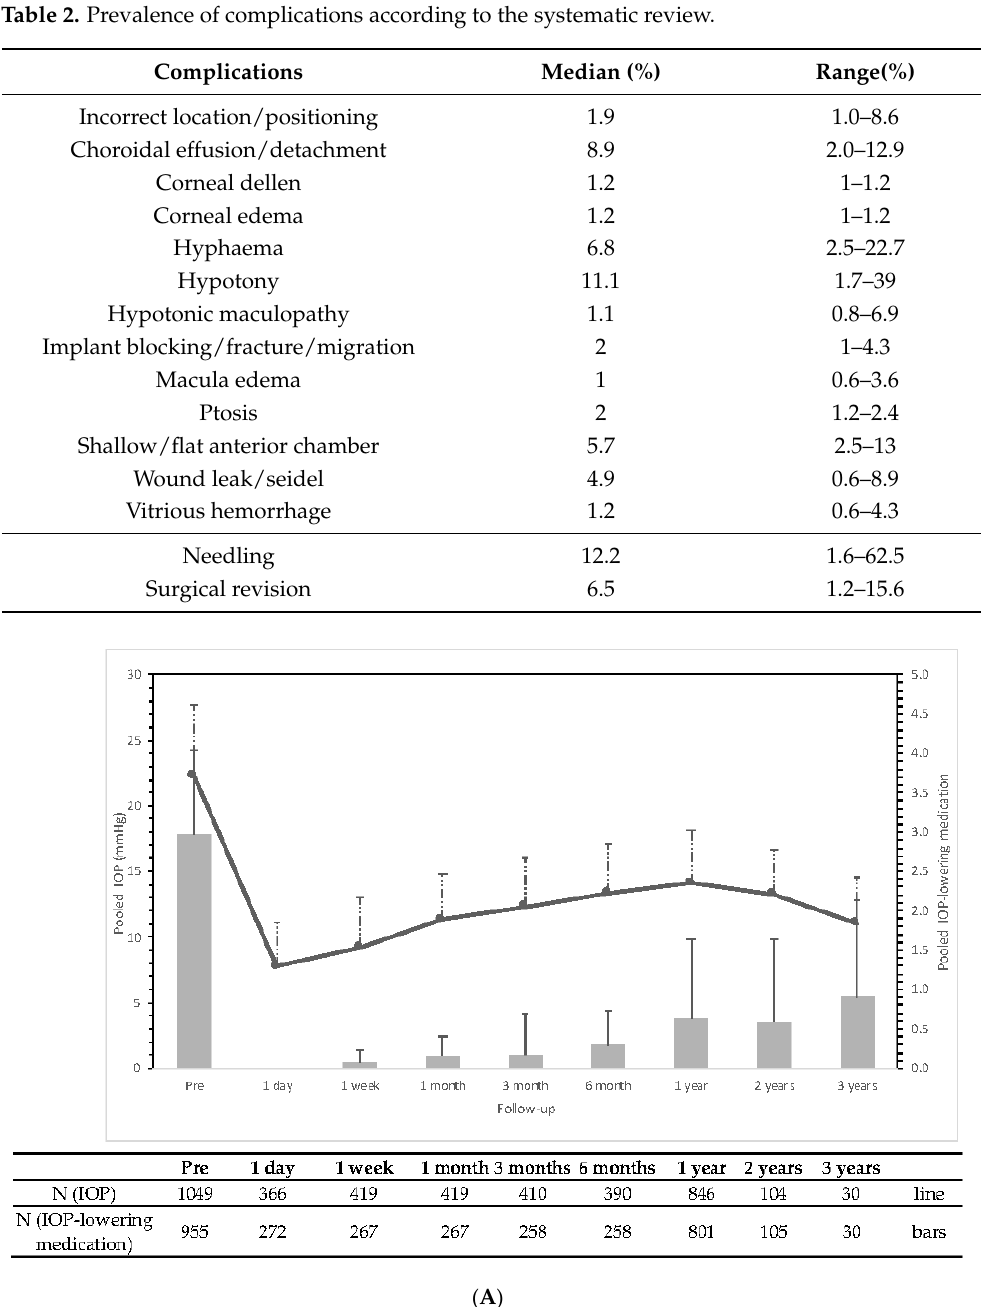
Table 2. Prevalence of complications according to the systematic review.